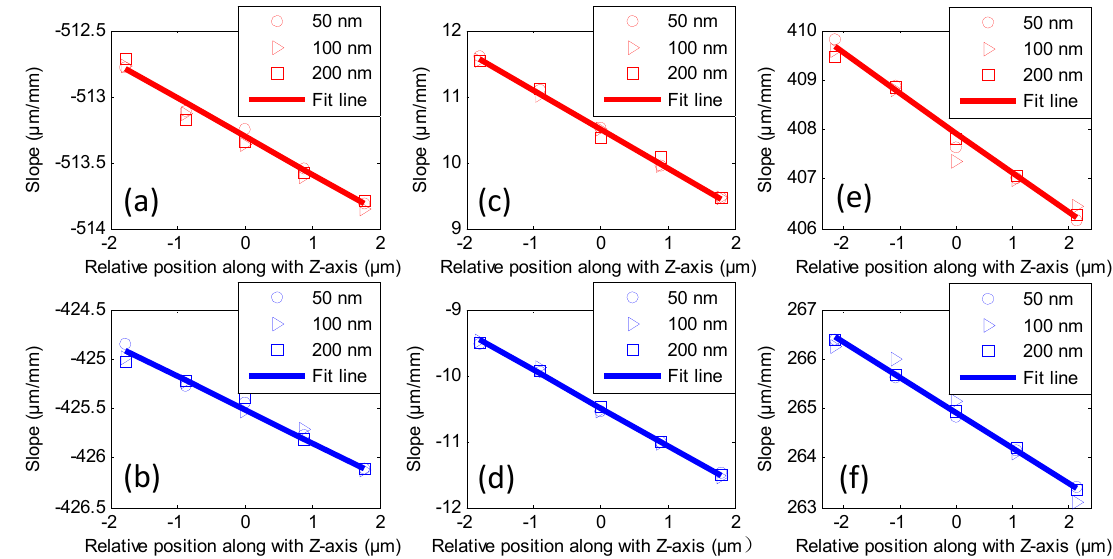
Figure 10. Slopes of coplanar displacement measurement error of the X-axis ( a ) and Y-axis ( b ) for M1, X-axis ( c ) and Y-axis ( d ) for M2, and X-axis ( e ) and Y-axis ( f ) for M3, respectively. After the above operations, the three fluorescent nanoparticles were dissolved in a silicone oil (refractive index: 1.392) to be the three test solutions. We synthesized the results of Figures 9 and 10, and Equation (2) to realize the nine cases of the fluorescent nanoparticle 3D tracking measurements and to validate the performance of the proposed micro-imaging system. The di ff usion constant D of the fluorescent nanoparticle had a relationship with its 3D MSD: MSD = 6 Dt + σ , where σ was the o ff set at time zero, accounting for the positional accuracy, and t was the time delay. Figure 11 shows the relationships between the MSD in each case and the corresponding di ff usion constant D .